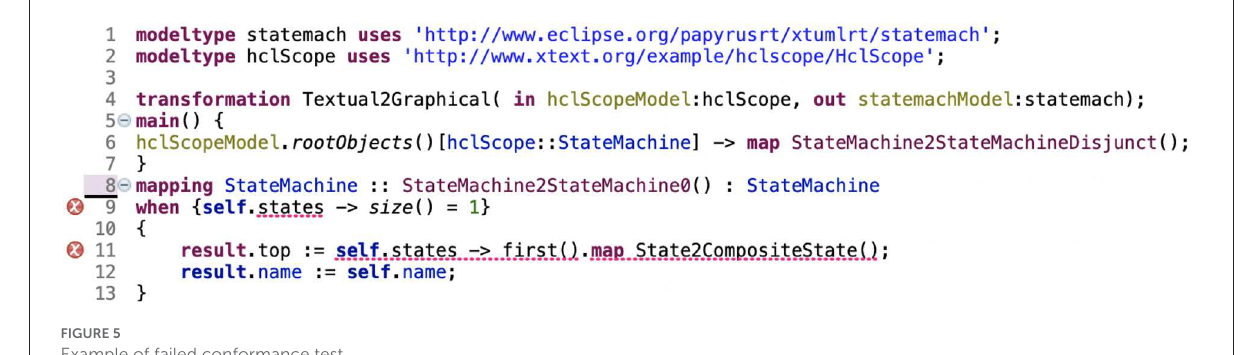
FIGURE5 Example of failed conformance